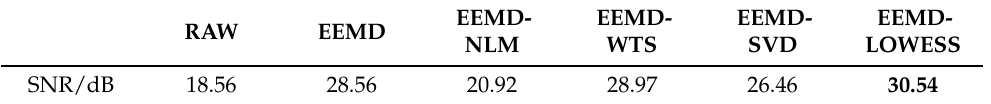
Table 6. Denoising performance of proposed algorithms compared with other methods. EEMD- RAW EEMD